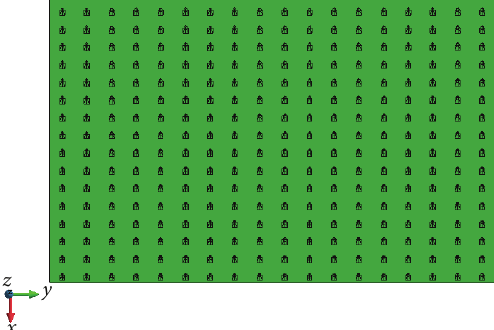
Figure 7: 16 × 18 mircostrip antenna array.